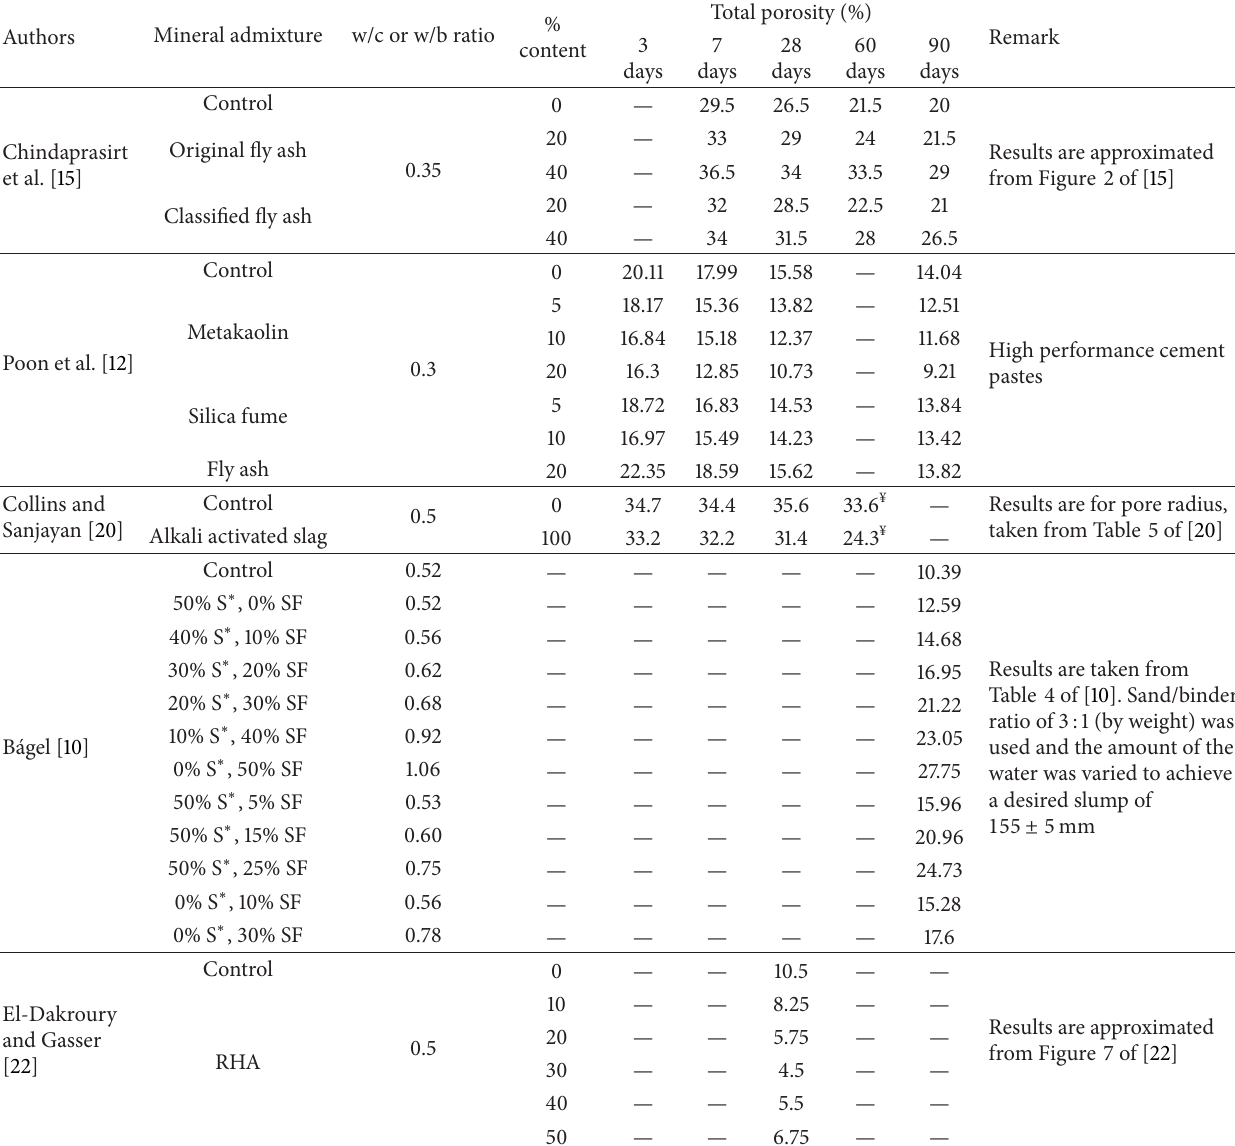
Table 2: Total porosity of cement replaced hardened pastes after partially replacing the cement content. Authors